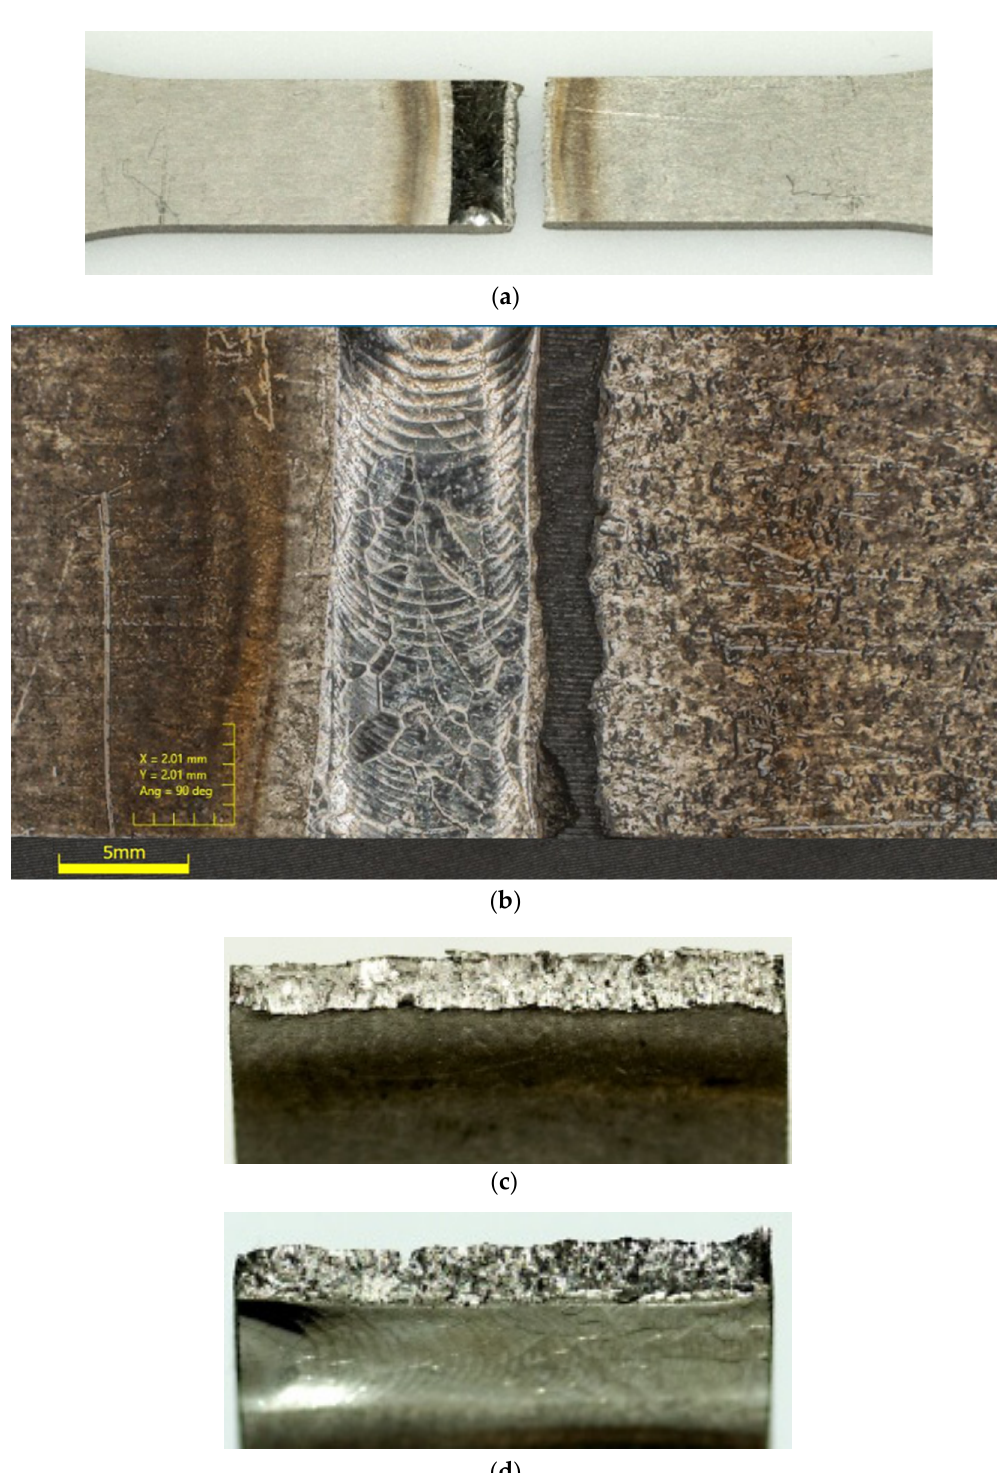
Figure 11. Macroscopic images of Type 3 specimen ( a , b ) and detailed image of its weld bead ( c ) before fatigue cracks.